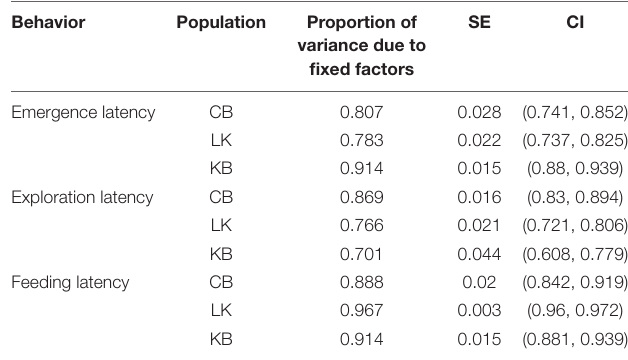
TABLE 9 | Proportion of variance caused due to fixed factors during calculation of enhanced agreement repeatability for Fish ID within populations.